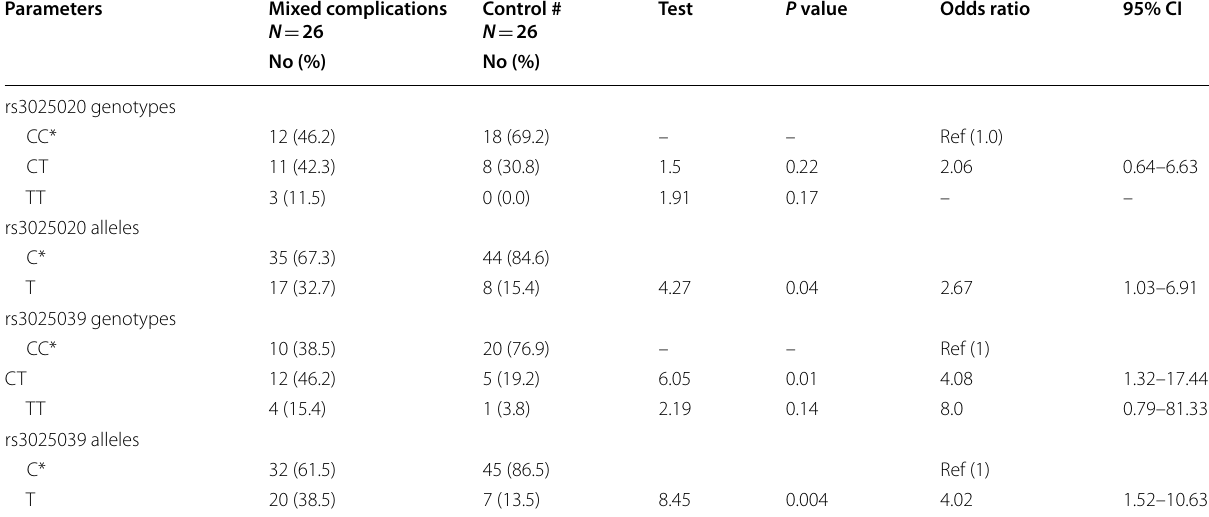
Table 3 VEGF-A rs3025020 and rs3025039 distribution and odds ratio assessment between control and T2DM with mixed complications